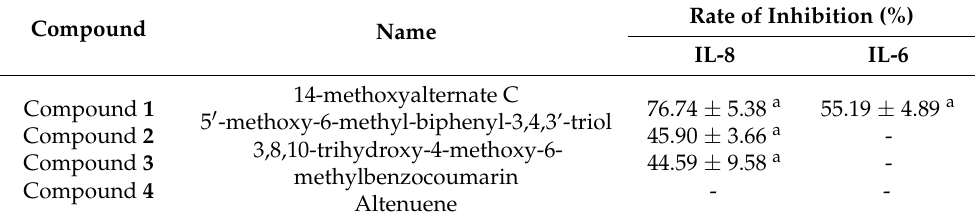
Table 1. Inhibitory effects of the four isolated compounds on IL-8 and IL-6 production in TNF- α /IFN- γ -treated HaCaT cells. Results are represented as the mean ± SD (n = 3). Compounds concentration: a —40 μ M.